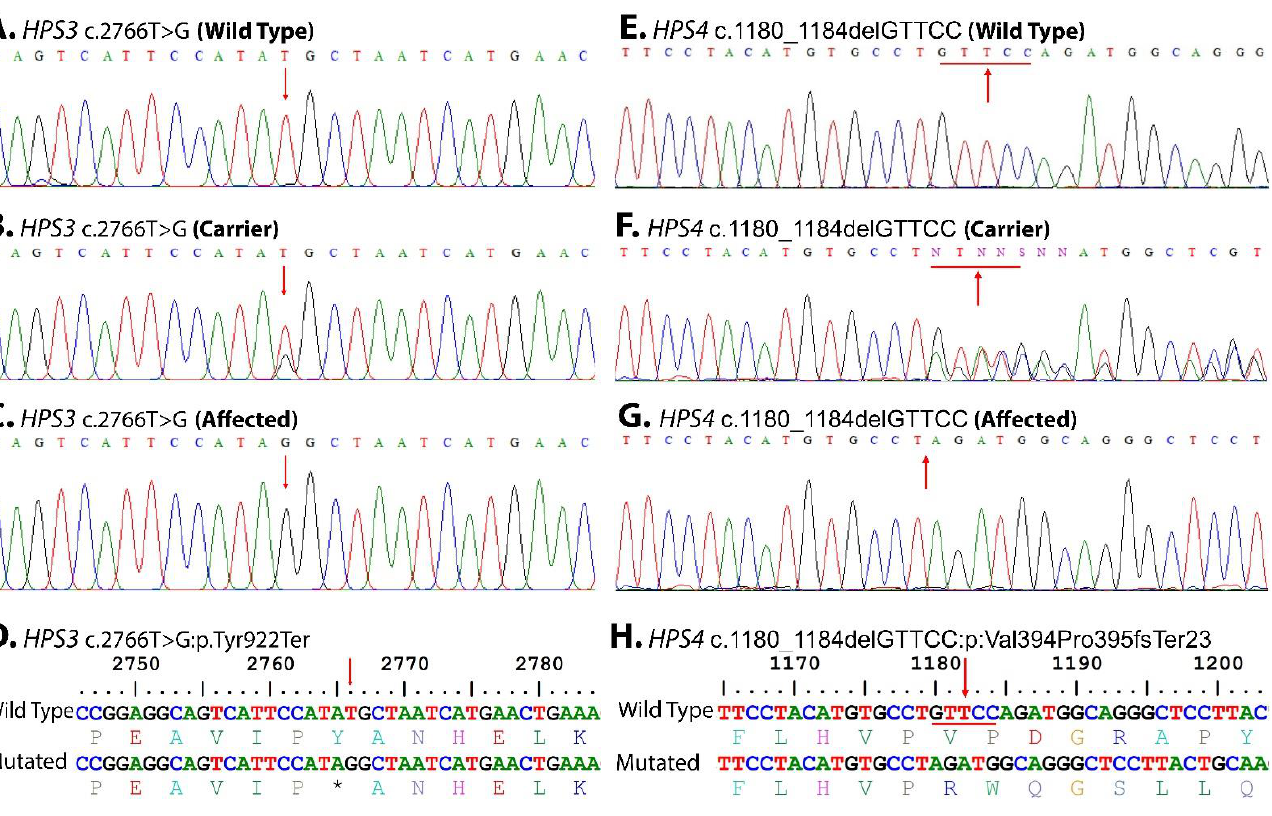
Figure 3. Sanger sequence trace files identified homozygous mutated, heterozygous carriers, hemizygous affected, and homozygous wild type for each gene, and the point of alteration is indicated by an arrow above the trace files as ( A – D ): HPS3 c.2766T > G, ( E – H ): HPS4 c.1180_1184delGTTCC. One litter translation of wild type and mutant confirms the altered proteins.